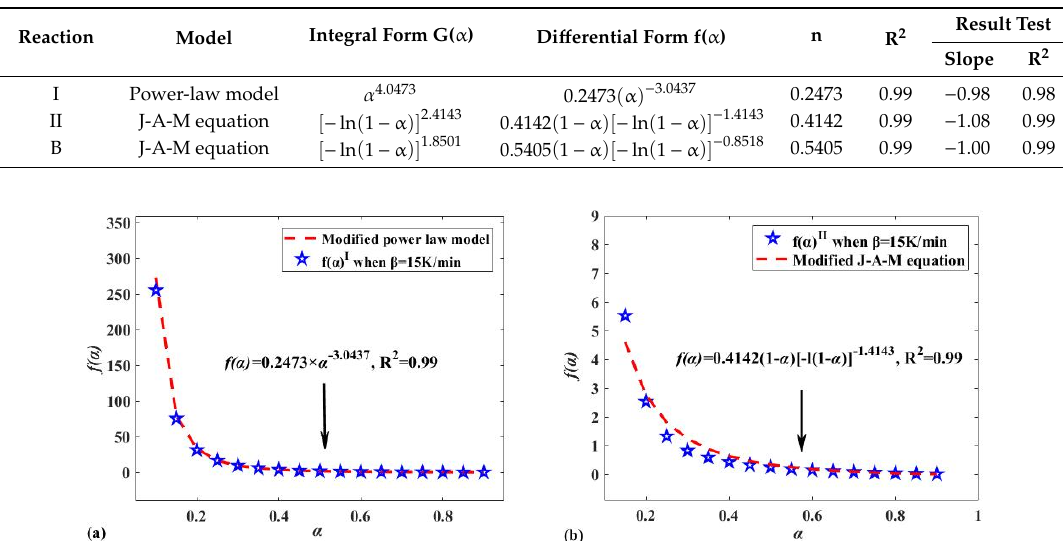
Figure 6. ( a ) The reconstructed experimental kinetic function 𝑓(α) of Reaction I compared to experimental data; ( b ) the reconstructed experimental kinetic function 𝑓(α) of Reaction II compared to experimental data.